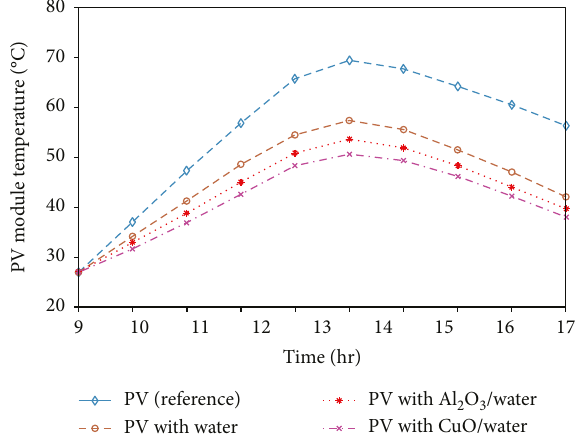
Figure 6: Variations of heat removal factor with inlet fl uid temperature using di ff erent receiver shapes and fl uids.